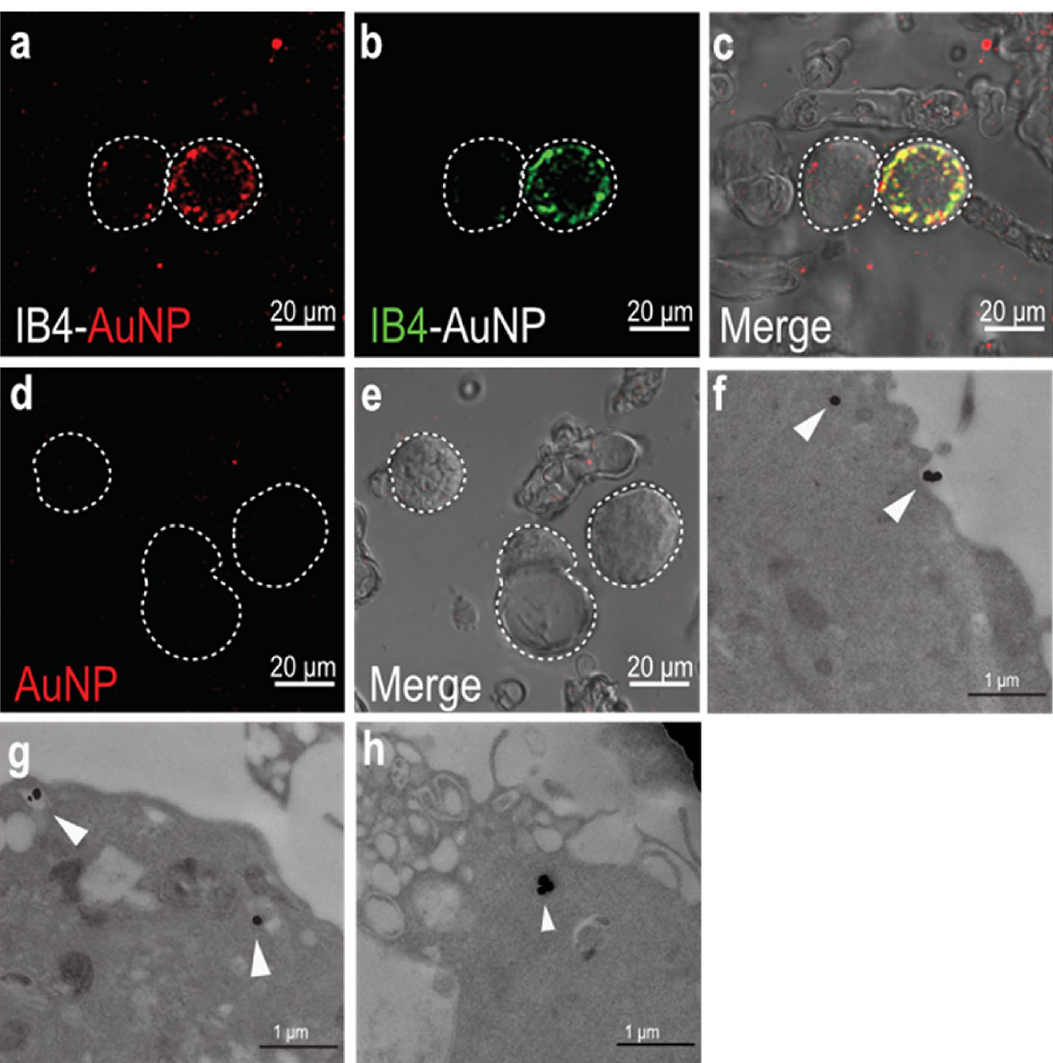
Figure 2. IB4-AuNP bind and enter cell bodies of dissociated sensory neurons. Representative confocal microscopy images of dissociated rat DRG neurons treated with FITC-tagged IB4-AuNPs (a–c) and non- functionalized AuNPs (d,e) . AuNP associated laser excited light-scattering signals (a) and FITC-IB4 associated signals (b) , were seen only in specific neurons, while absent in others, indicating IB4 selectivity. Representative TEM images of gold nanoparticles (f) binding to DRG cell membrane, and undergoing endocytosis, with nanoparticles localized in well-formed endosome ( g,h